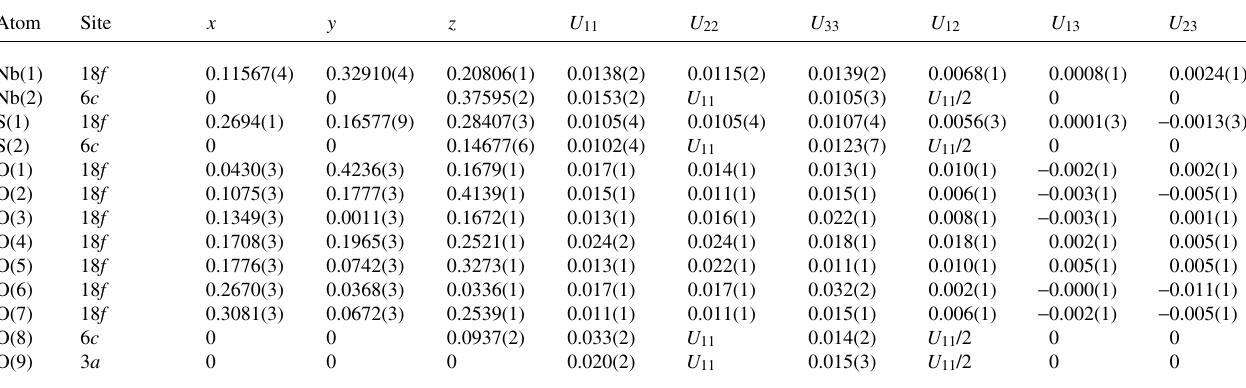
Table 2. Atomic coordinates and displacement parameters (in Å 2 )